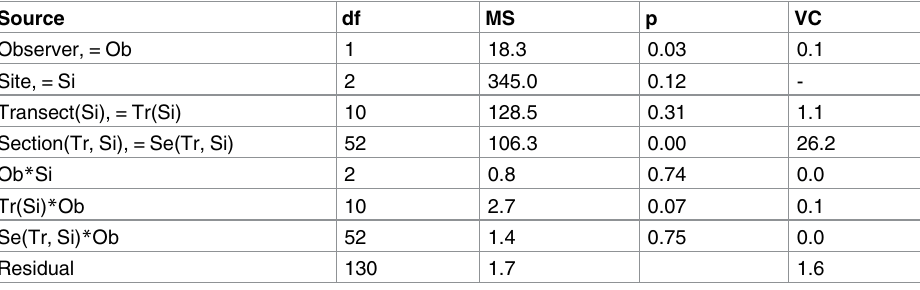
Table 3. Analysis of varianceand variancecomponents.